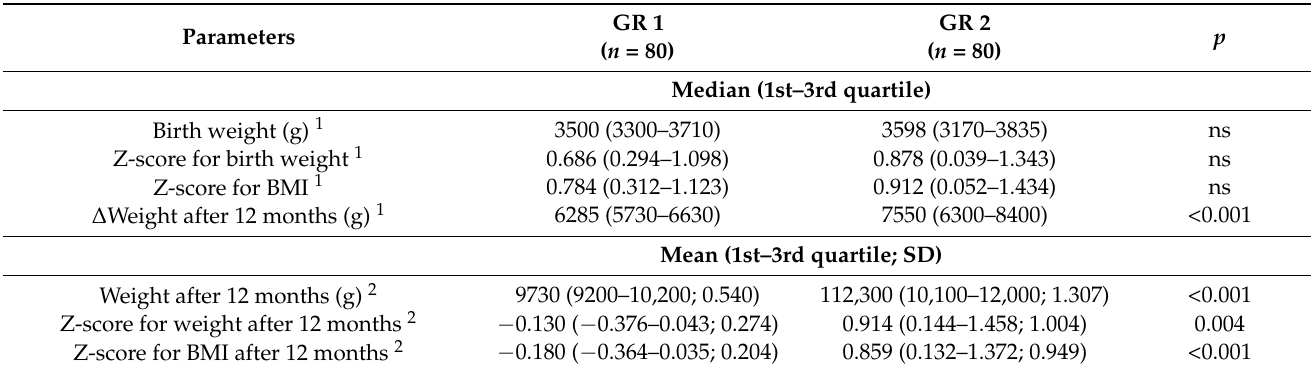
Table 2. Body weight in